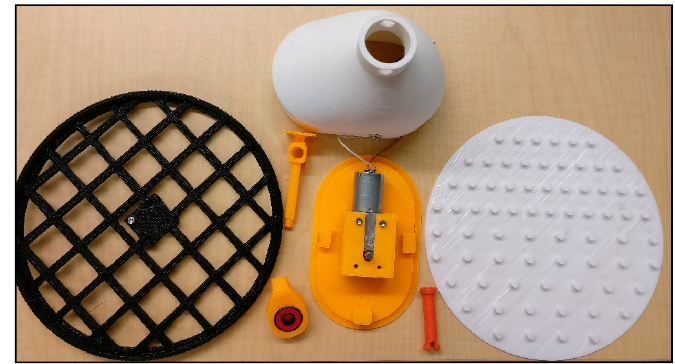
Figure 1. Disassembled 3-D printed components of the open source nutating mixer. The functionality for each 3-D printed component is described below: